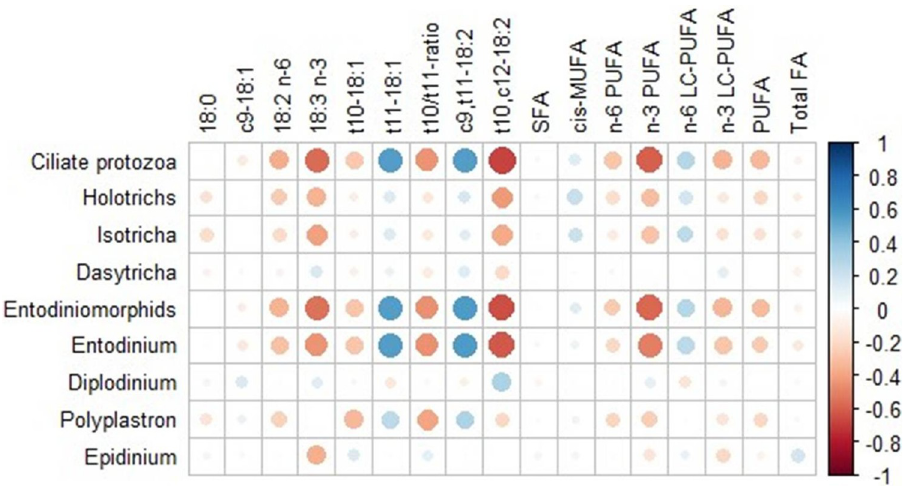
Fig 4. Significant correlations among ciliates (log 10 cells/ml) and fatty acids (g/100g FA) of longissimus muscle of lambs. The strongest Spearman´s correlations are represented by large circles, while the weakest correlations are represented by small circles. The colors and their intensity on the bar scale denote the nature of the correlation, with the darker shade of blue indicating more positive correlations (close to 1) and the darker shade of red indicating more negative correlations (closer to -1) (n = 86). SFA, Saturated fatty acids; cis -MUFA, cis monosaturated fatty acid; PUFA, Polyunsaturated fatty acids; n-6 PUFA, 18:2 n-6 + 20:4 n-6 + 22:4 n-6;LC n-6 PUFA, 20:4 n-6 + 22:4 n-6;